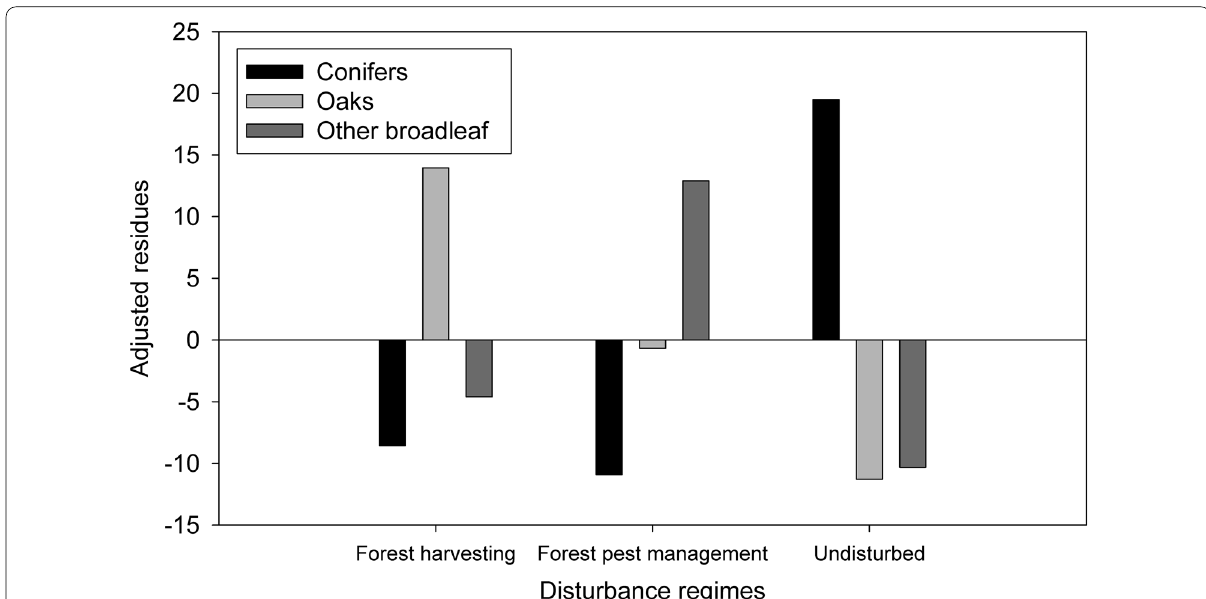
Fig. 4 Haberman’s adjusted residues values of the number of the individuals by recruitment for each disturbance regime (H, forest harvesting; P, forest pest management; U, undisturbed areas). Values higher than and values lower than